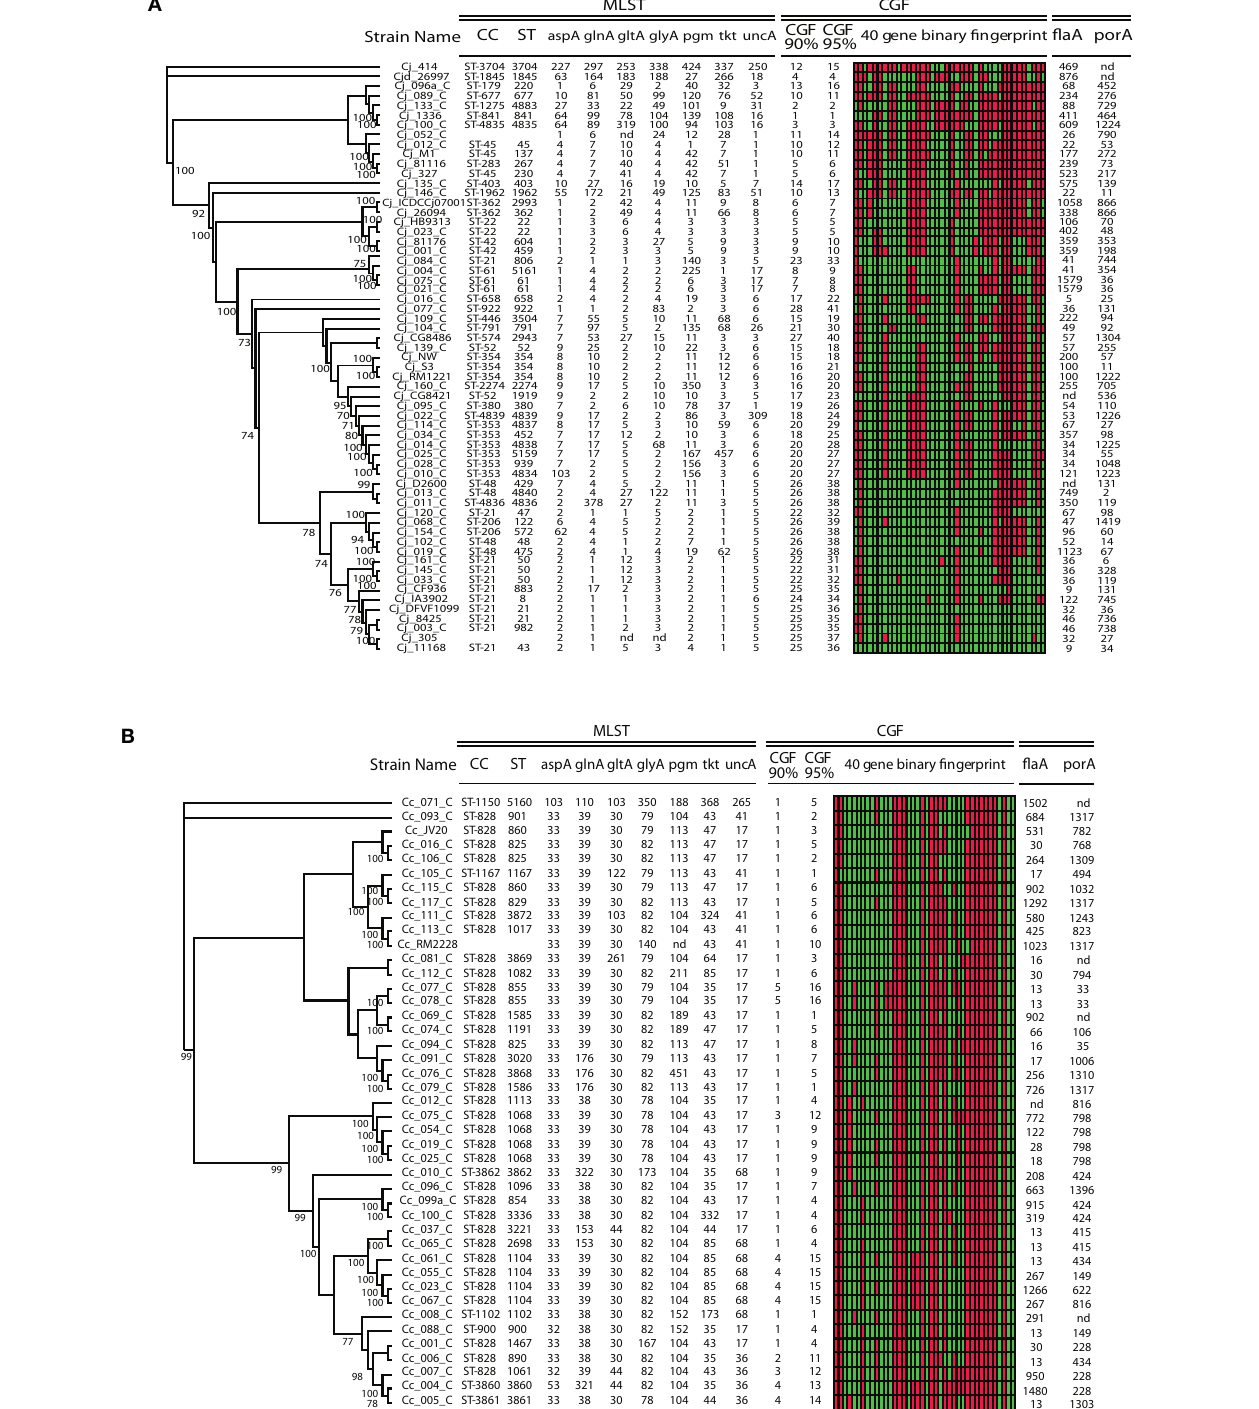
FIGURE 3 | In silico typing data derived from C. jejuni and C. coli and WGS is concordant with core genome phylogeny. Publicly availableWGS data for 104 C. jejuni (A) and C. coli (B) strains were used to derive typing profiles using an in silico typing pipeline. Although the dataset is comprised of highly genetically diverse strains, there is concordance between molecular